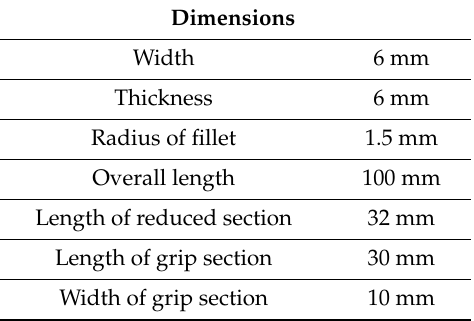
Table 3. Parameters of the tensile specimens.